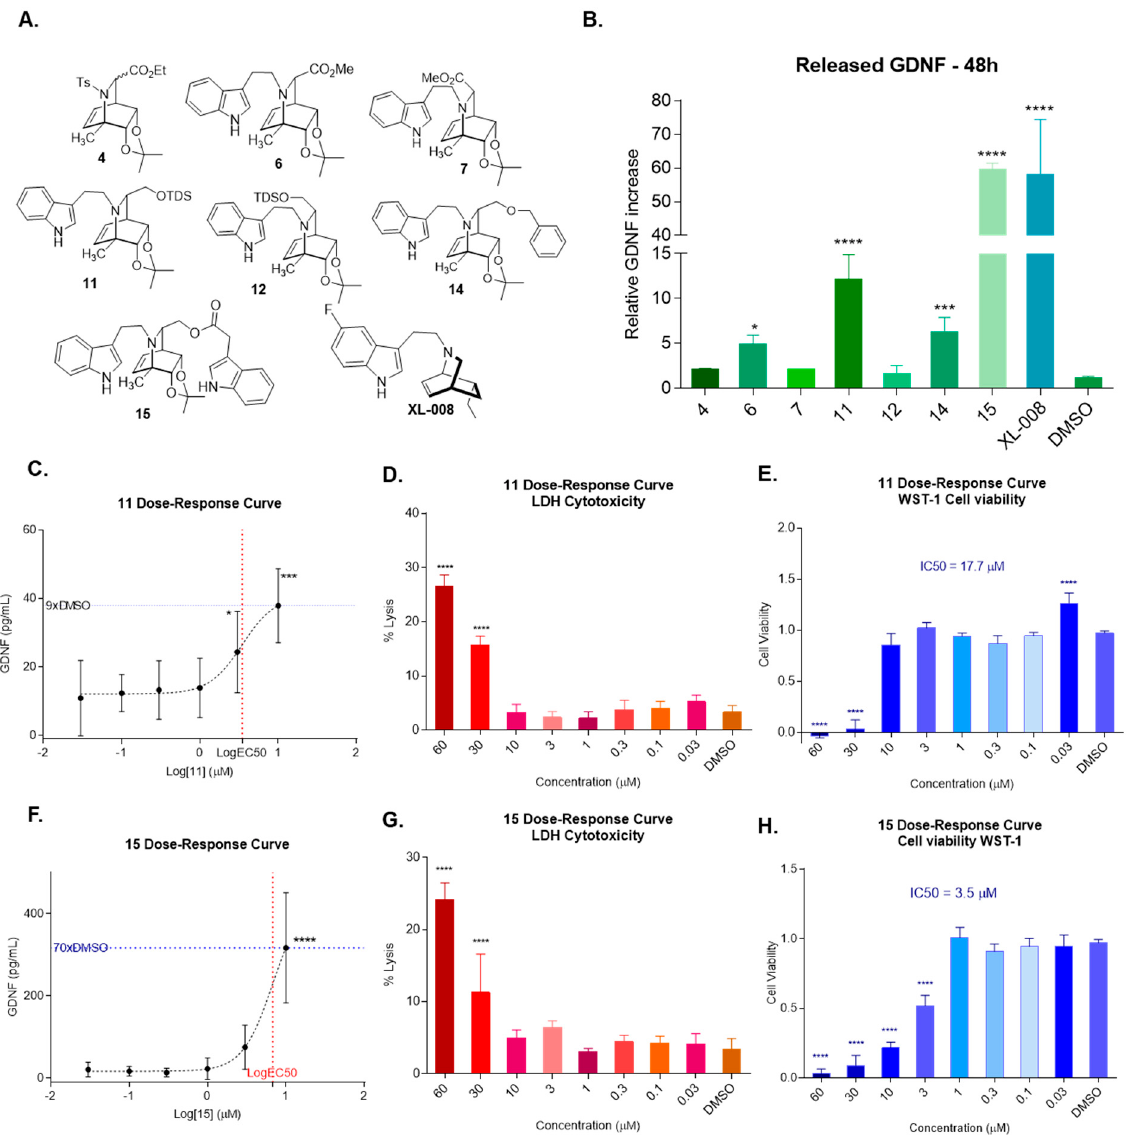
Figure 5. ( A ) Chemical structure of iboga-like compounds tested on their ability to promote GDNF release. ( B ) GDNF released by C6 cells after 48 h treatment with compounds shown in Figure 5A at 10 μ M concentration. ( C ) 11 dose-response curve after 48 h treatment. ( D ) 11 ′ s effect on cell lysis determined by LDH assay. ( E ) 11 ′ s effect on cell viability determined by WST-1 assay. ( F ) 15 ′ s dose-response curve after 48 h treatment. ( G ) 15 ′ s effect on cell lysis determined by LDH assay. ( H ) 15 ′ s effect on cell viability determined by WST-1 assay. Statistics: data represent mean ± SEM of 3